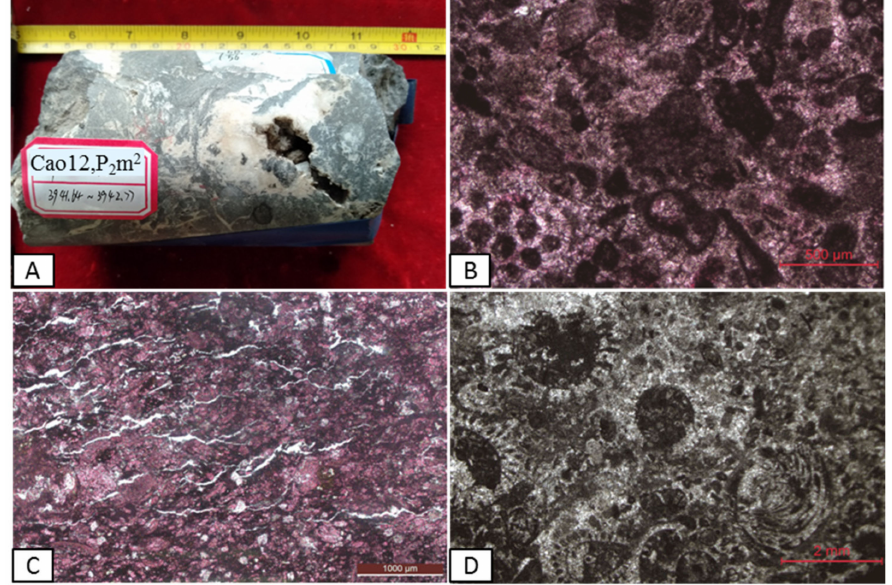
Figure 4. Petrological characteristics of intra-platform high-energy shoal in P 2 m 2 a, Eastern Sichuan. ( A ) Sparry arenaceous and bioclastic limestone with unfilled dissolved pores in well Cao12. ( B ) Sparry bioclastic and arenaceous limestone in well Xiang14. ( C ) Dolomitic limestone with a high degree of biological sparry in well Cao12. ( D ) Sparry algal clast limestone in well